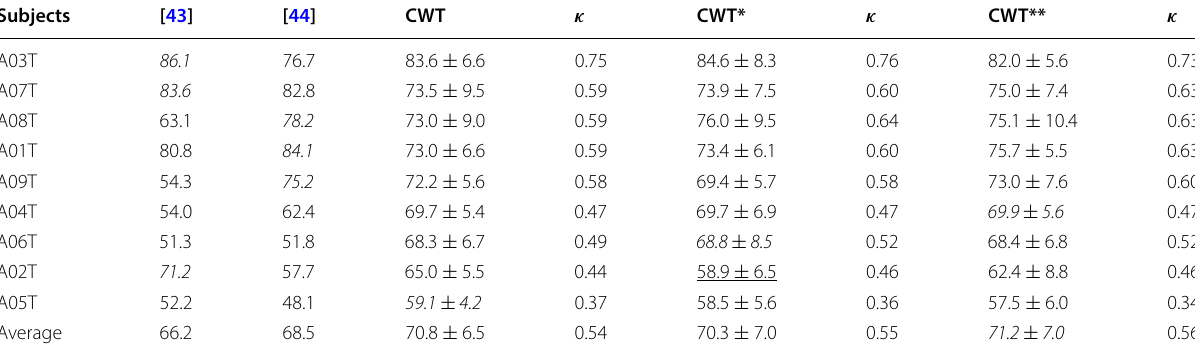
presented for motor imagery classification (left and right